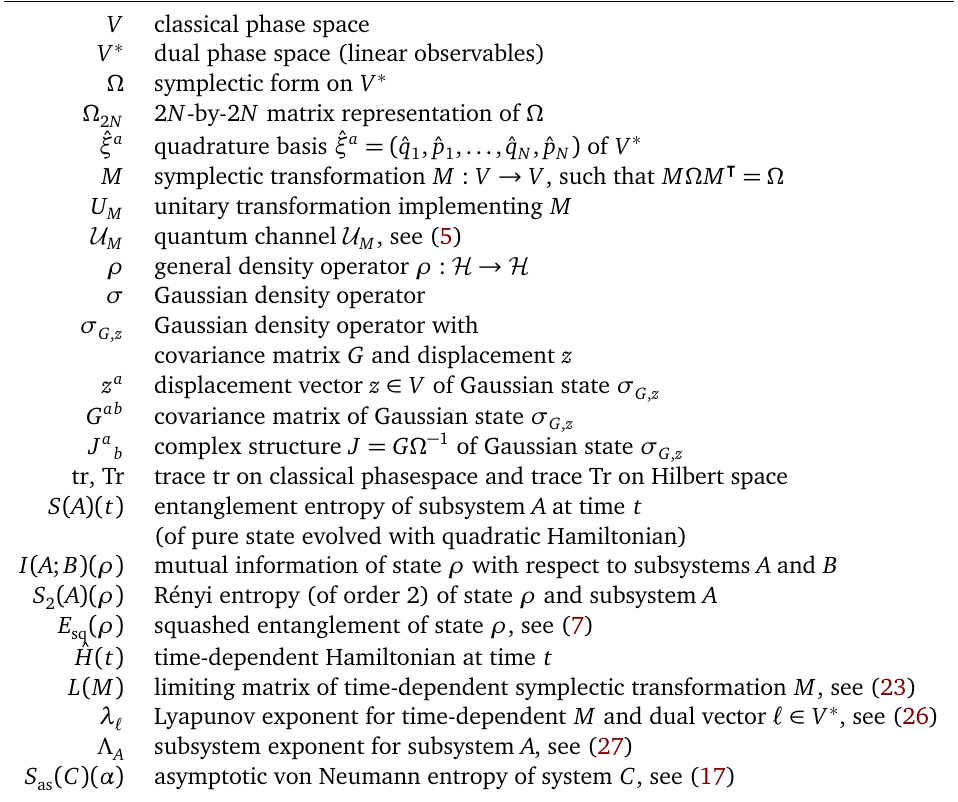
Table 1: Conventions and notation. We list the most common symbols and how they are used in this